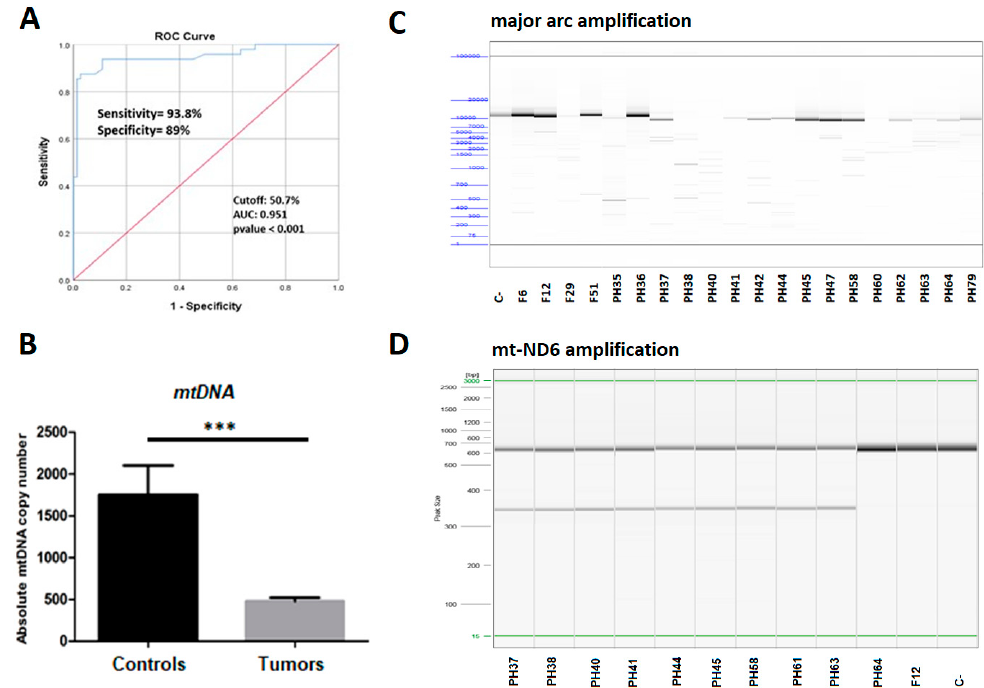
Figure 3. Mitochondrial DNA depletion and large deletions analysis. ( A ) ROC curve to assess the optimal cutoff value of mitochondrial DNA copy number (51%). AUC, area under the curve; ROC, receiver operating characteristic. ( B ) Absolute mtDNA copy number in the PCCs/PGLs (Swedish and French cohorts) and controls (normal adrenal medulla tissues); p -values were calculated by t -test, *** <0.0001. ( C ) Large mitochondrial DNA deletions detected in PCCs/PGLs from the Swedish and the French cohort, using the Fragment Analyzer. ( D ) Gel electrophoresis separation of a 300 bp heteroplasmic deletion detected in MT-ND6 gene, using QIAxcel (Qiagen) in 9 tumors from the Swedish cohort (right). (C-: negative control yielded the expected band